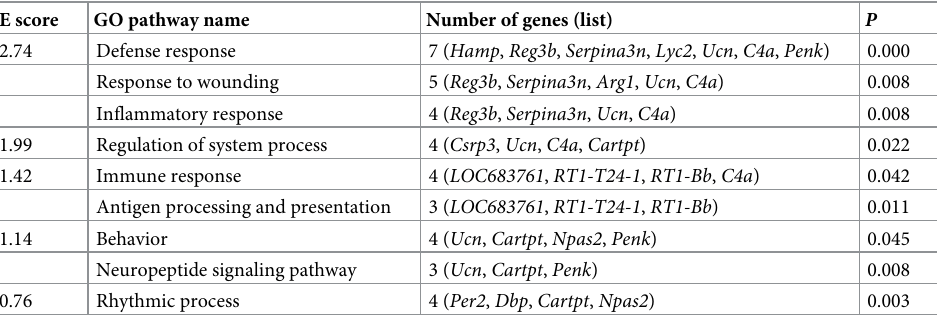
Table 2. Gene Ontology (GO) process in functional annotation clustering analyses of significant regulated genes.